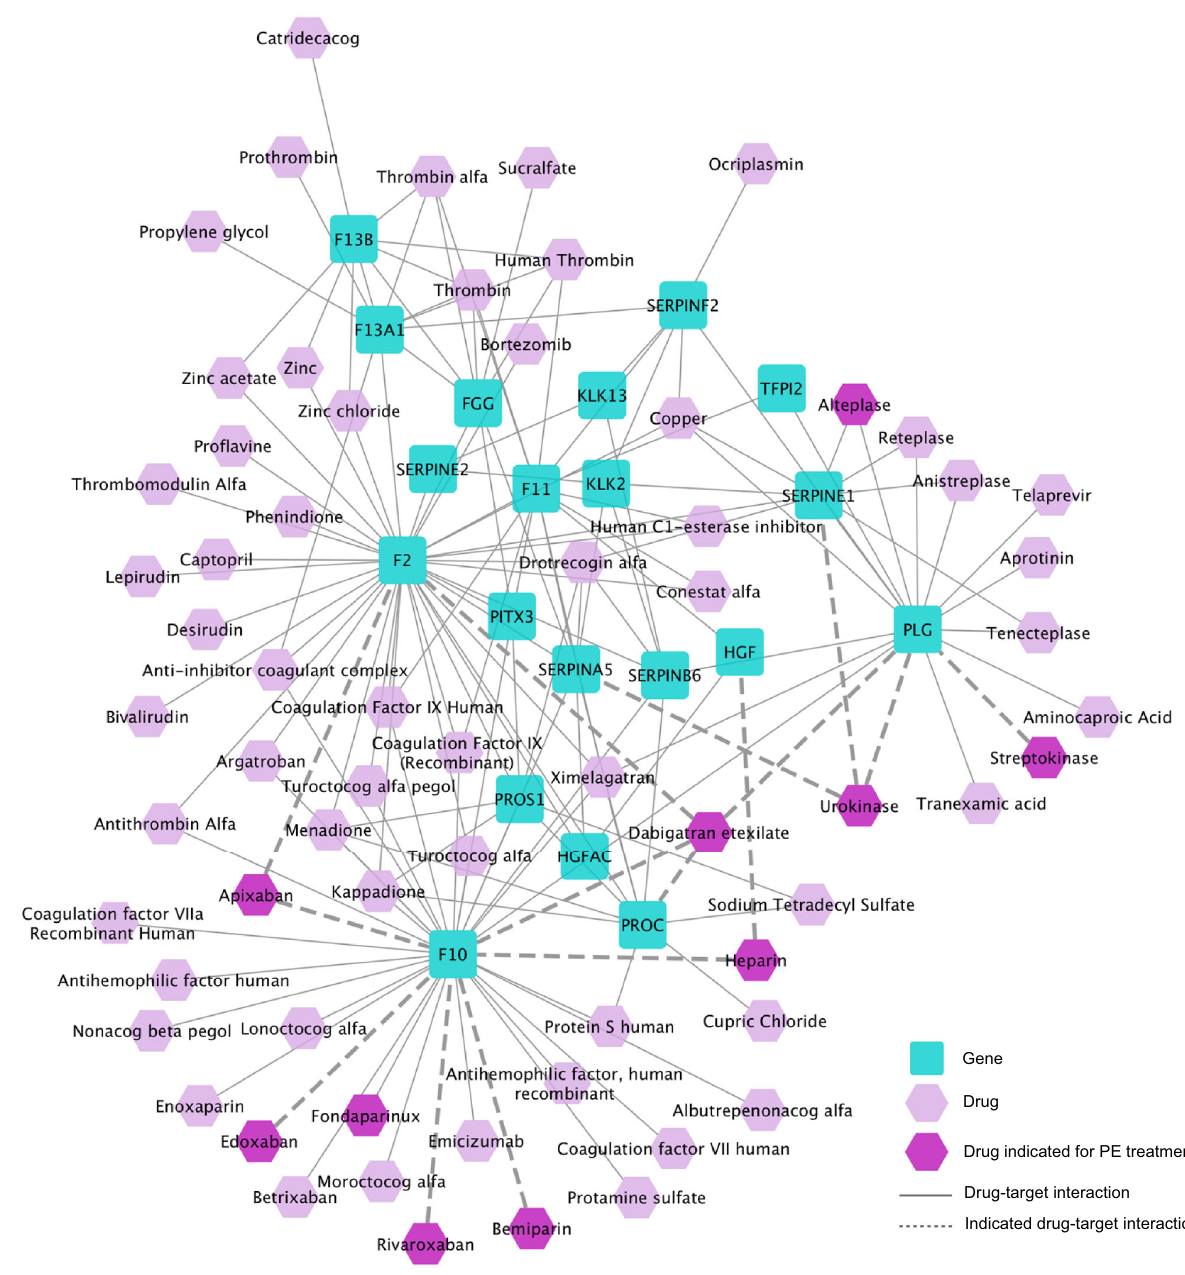
Fig. 4 The pulmonary embolism disease module and its targeting top-ranked drugs. The PE disease module (excluding the initial seeds) derived by DIAMOnD, combined with its targeting 50 top-ranked